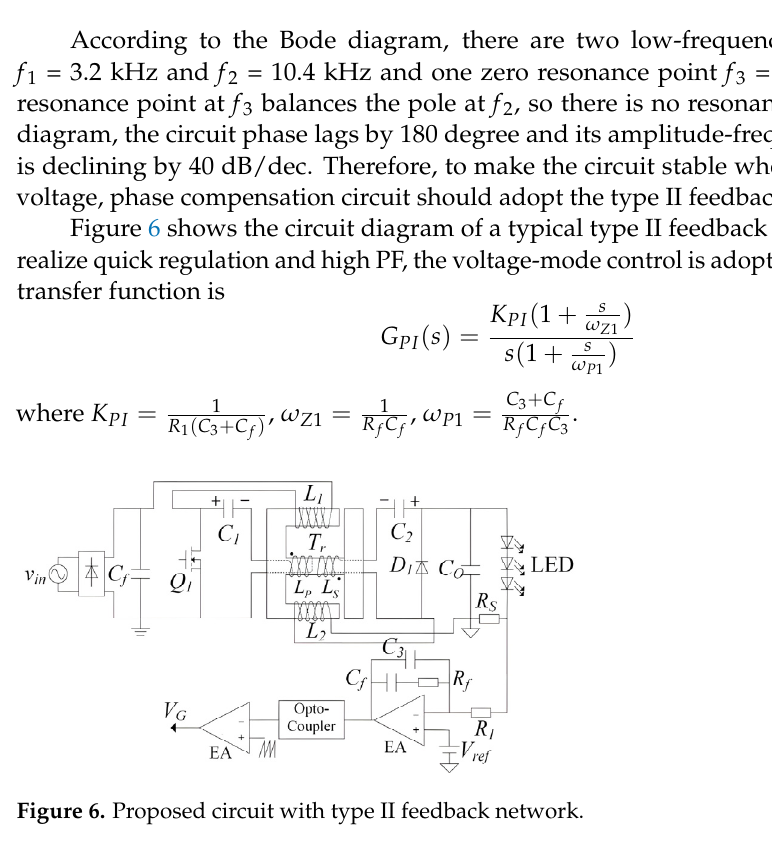
Figure 5. Bode diagram of G vd ( s ).